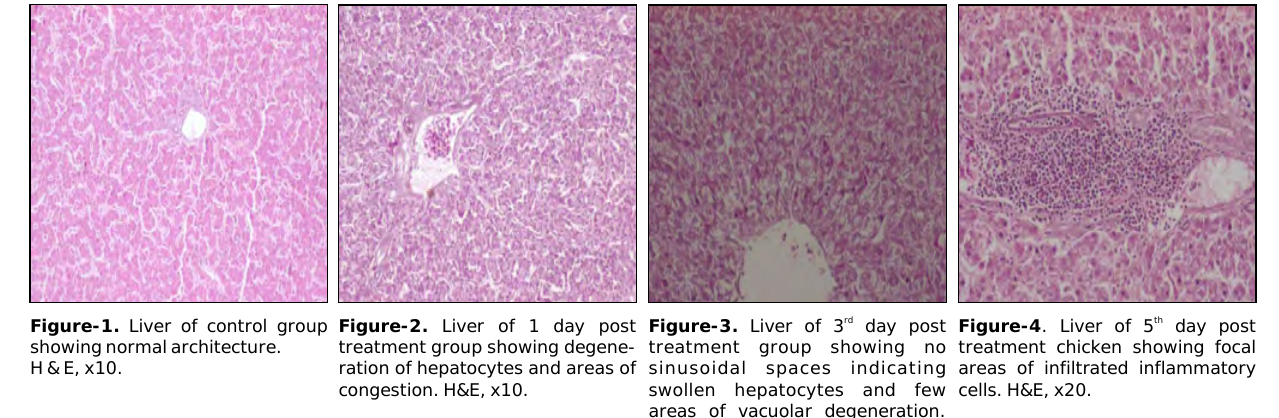
Figure-1. Liver of control group showing normal architecture. H & E, x10.